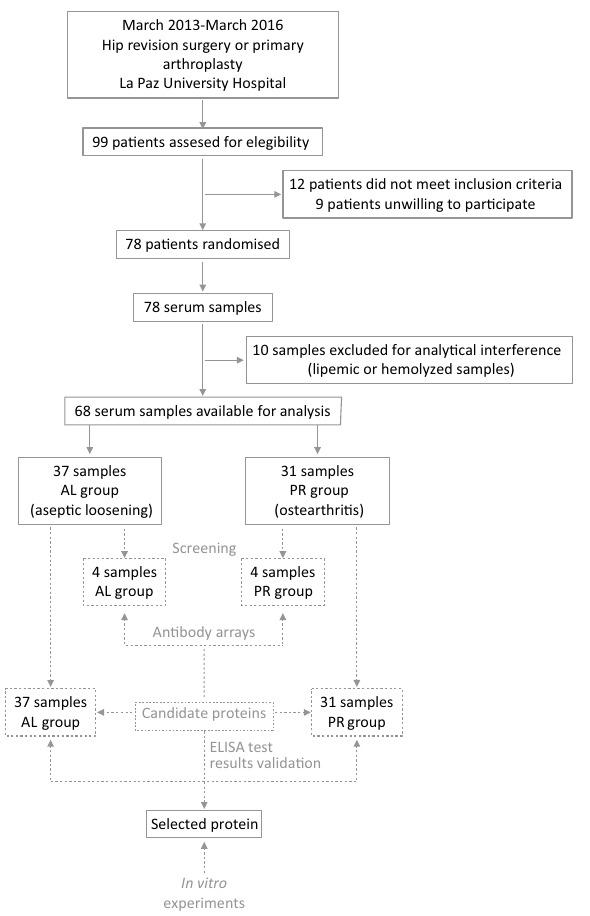
Figure 1. Flow diagram showing the disposition of patients and the overall study design. Continuum lines summarize the patient recruitment and origin of the serum samples. Dashed lines summarize the protocol employed for the